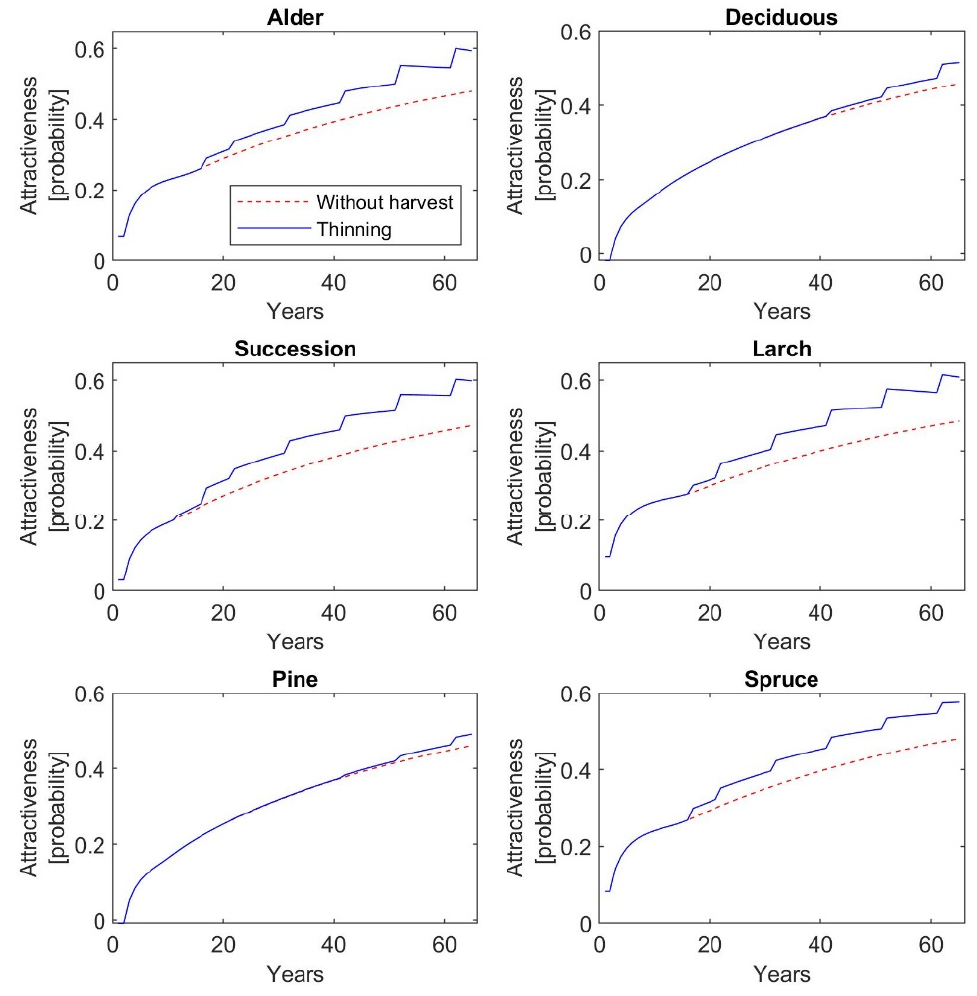
Figure 8. Predicted recreation value over 65 years without harvest and under different thinning regimes and forest types.